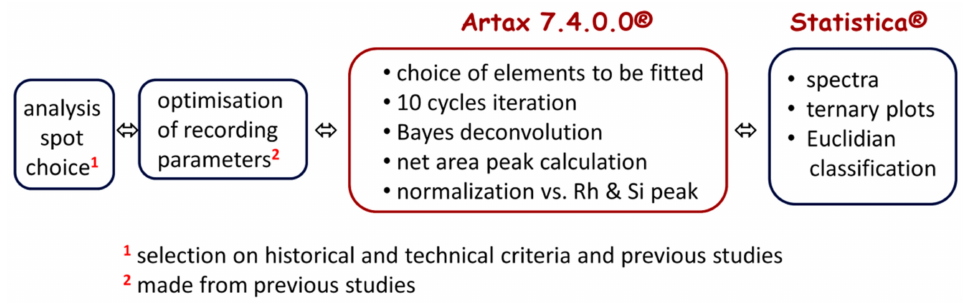
Figure 4. Flowchart of the XRF study and data evaluation